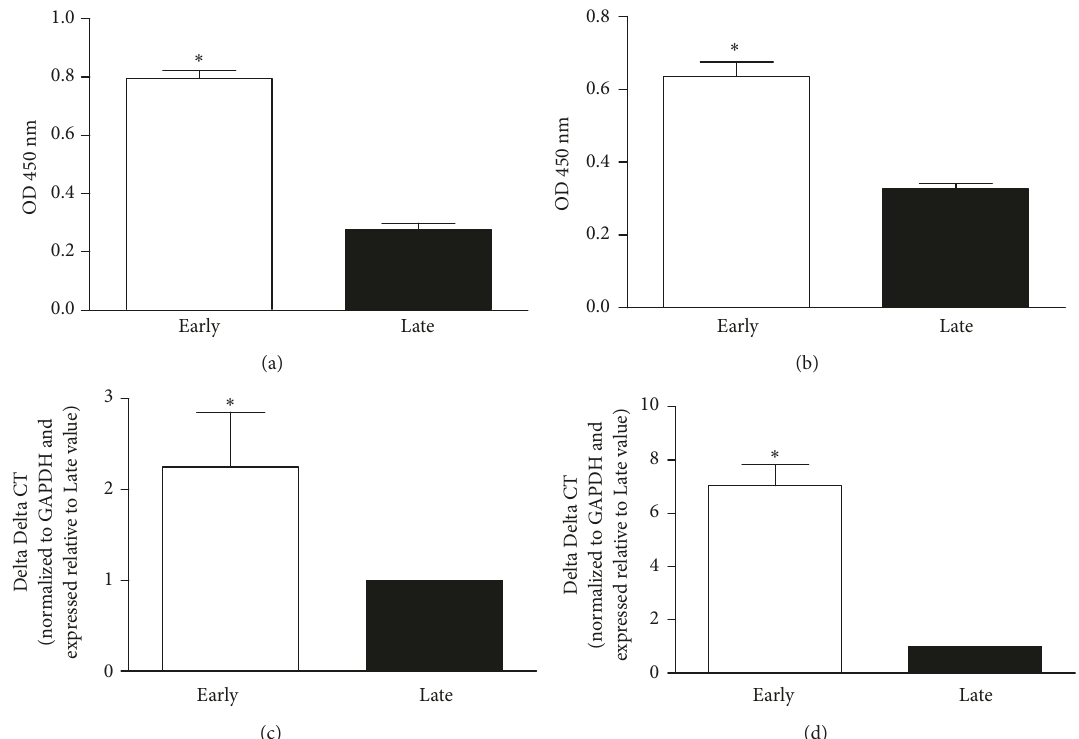
Figure 1: Expression of ER 𝛼 and ER 𝛽 in GSMC from early- and late-pregnant rats. (a) and (b) Representative protein expression levels of ER 𝛼 and Er 𝛽 , respectively, by ELISA. Protein expression level is expressed as OD 450nm. ER 𝛼 and ER 𝛽 proteins were more expressed in GSMCs from early-pregnant rats compared with those in GSMCs from late-pregnantrats. (c) and (d) Messenger RNA levels of ER 𝛼 and ER 𝛽 were measured by qRT-PCR in RNA isolated from the GSMC of early- and late-pregnantanimals and expressed as delta delta CT normalized to GAPDH and relative to level in late-pregnant sample. ER 𝛼 and ER 𝛽 mRNAs were more expressed in GSMCs from early-pregnant rats compared with those in GSMCs from late-pregnant rats. Values shown are representative of three independent experiments performed in triplicate. ∗ P < 0.05 measurements in early-pregnant rats are significantly different from corresponding measurements in late-pregnant ones.